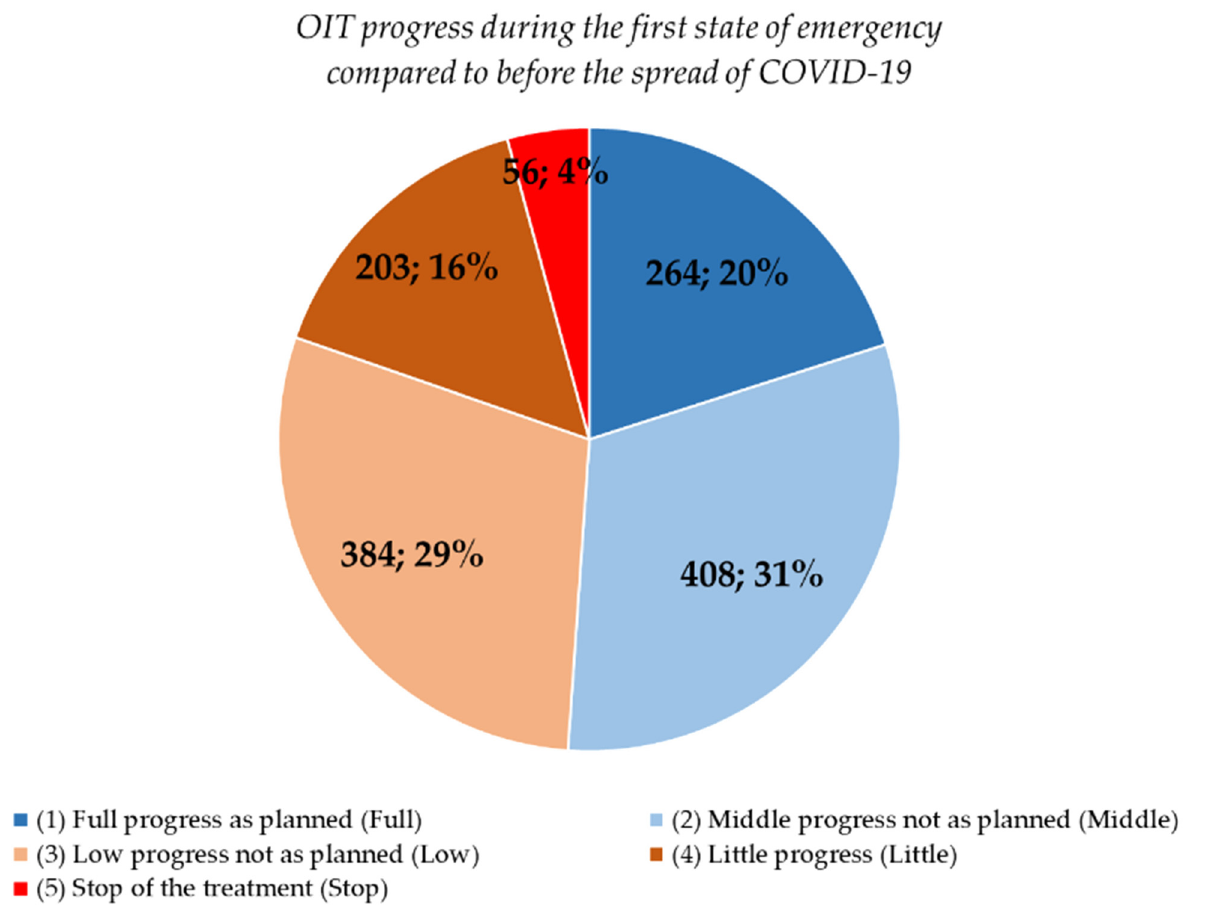
Figure 2. Progress of home-based oral immunotherapy (OIT) in the first state of emergency. Data are shown as the number of respondents and percentage (parents).